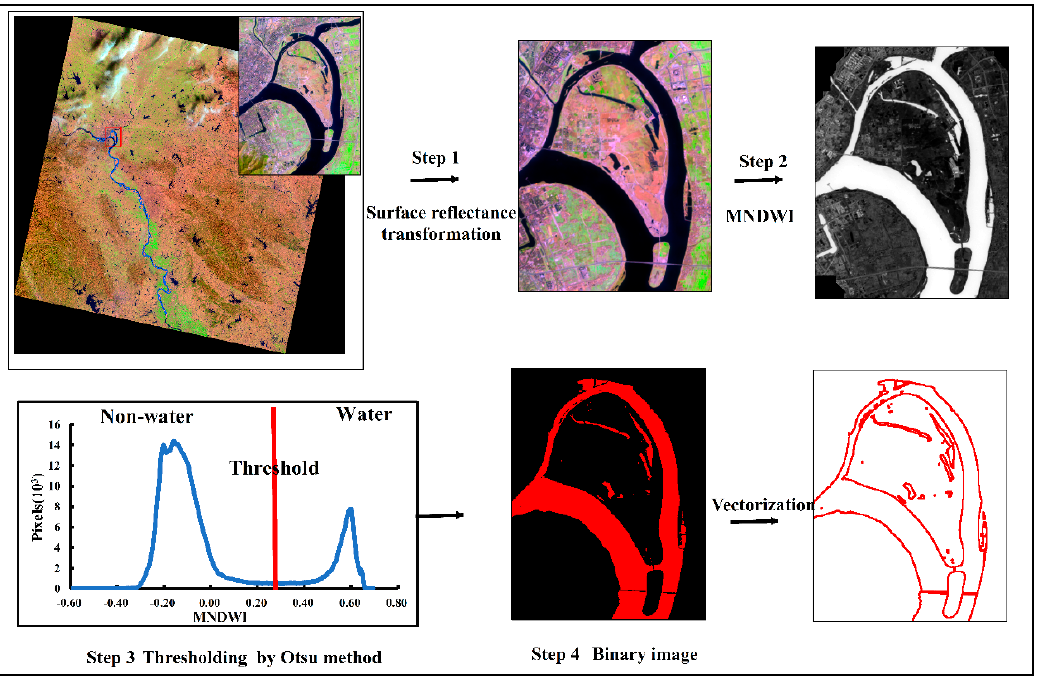
Figure 2. Channel bar automatic extraction steps (example using Landsat-8 image in false color with